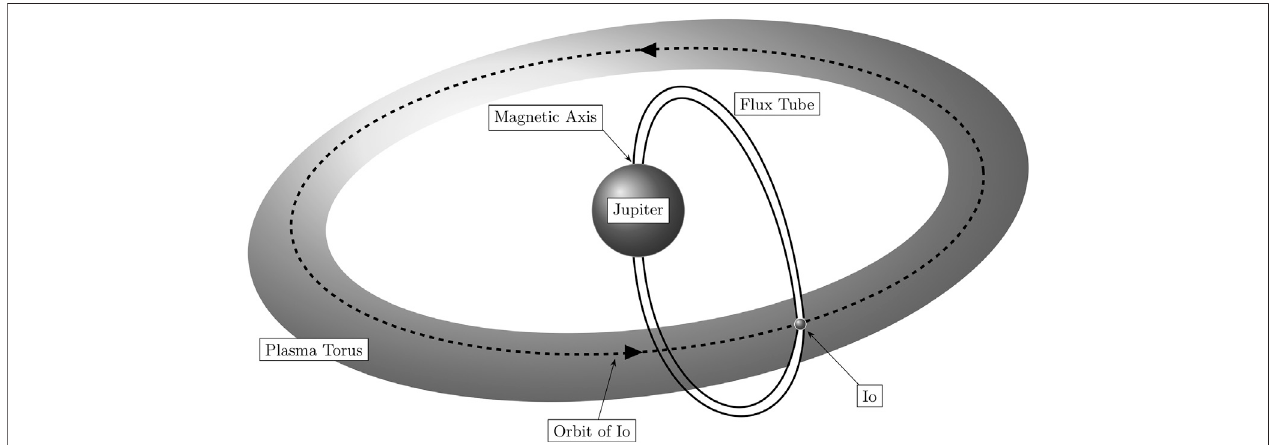
FIGURE 2 | Io ’ s electrodynamic interaction is unique due to its fast rotation and the in fl uence of the strong magnetic fi eld of Jupiter. Plasma interactions with Io ’ s atmosphere lead to mass loss in the form of ions and neutrons. These neutrons then ionize through radiative effects and accumulate around Io forming a plasma torus. Consequently,this fl owofmagnetizedplasmapasttheobstacleIo,combinedwithatmosphericinteractions,aretheenginebehindIo ’ splasmainteractionswithJupiter ’ s